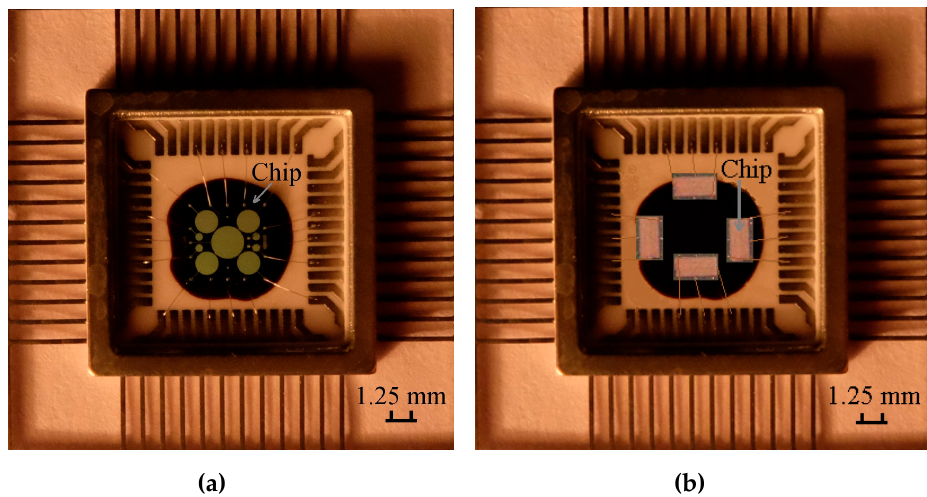
Figure 1. Photography of the radiation metal-oxide-semiconductor (MOS) sensors based on the MOS capacitors ( a ) and four p-channel MOSFETs (radiation sensitive field effect transistors (RADFETs)) ( b ) enclosed into a metal-ceramic package.